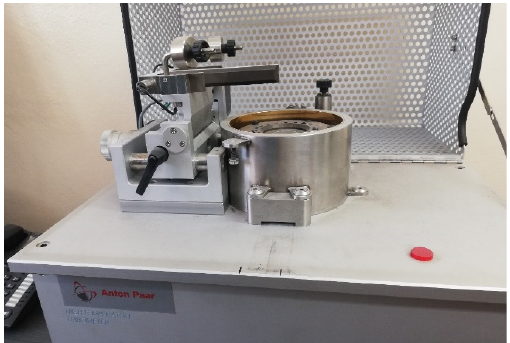
Figure 3. Stand for friction wear tests in laboratory conditions. The following measurement parameters were determined